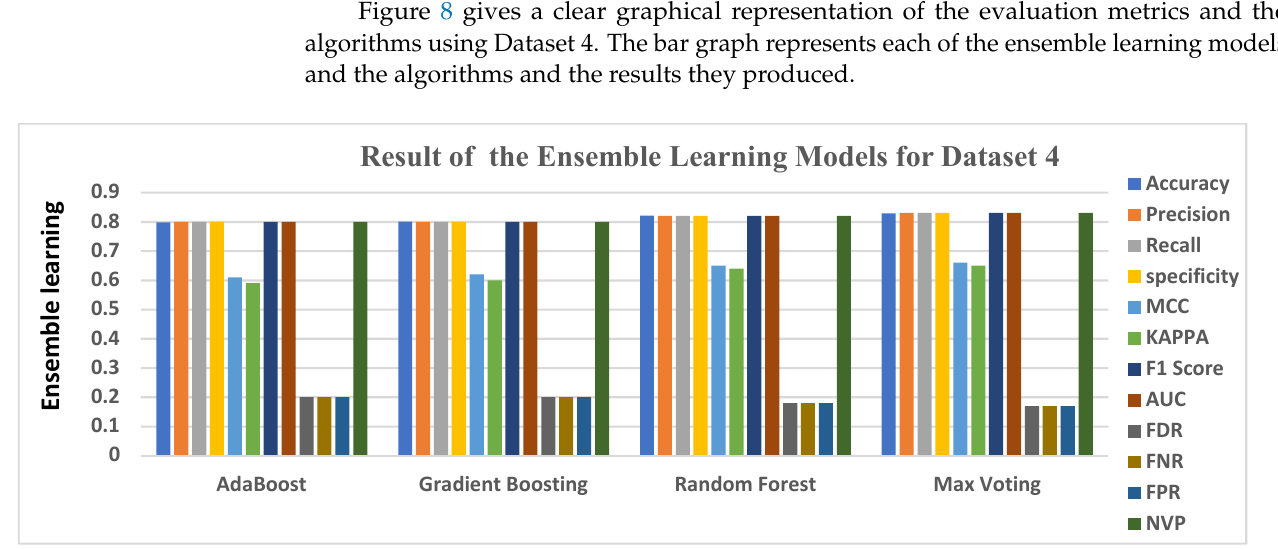
Figure 8. Graphical representation of Evaluation Metrics against Ensemble Learning Models for Dataset 4.